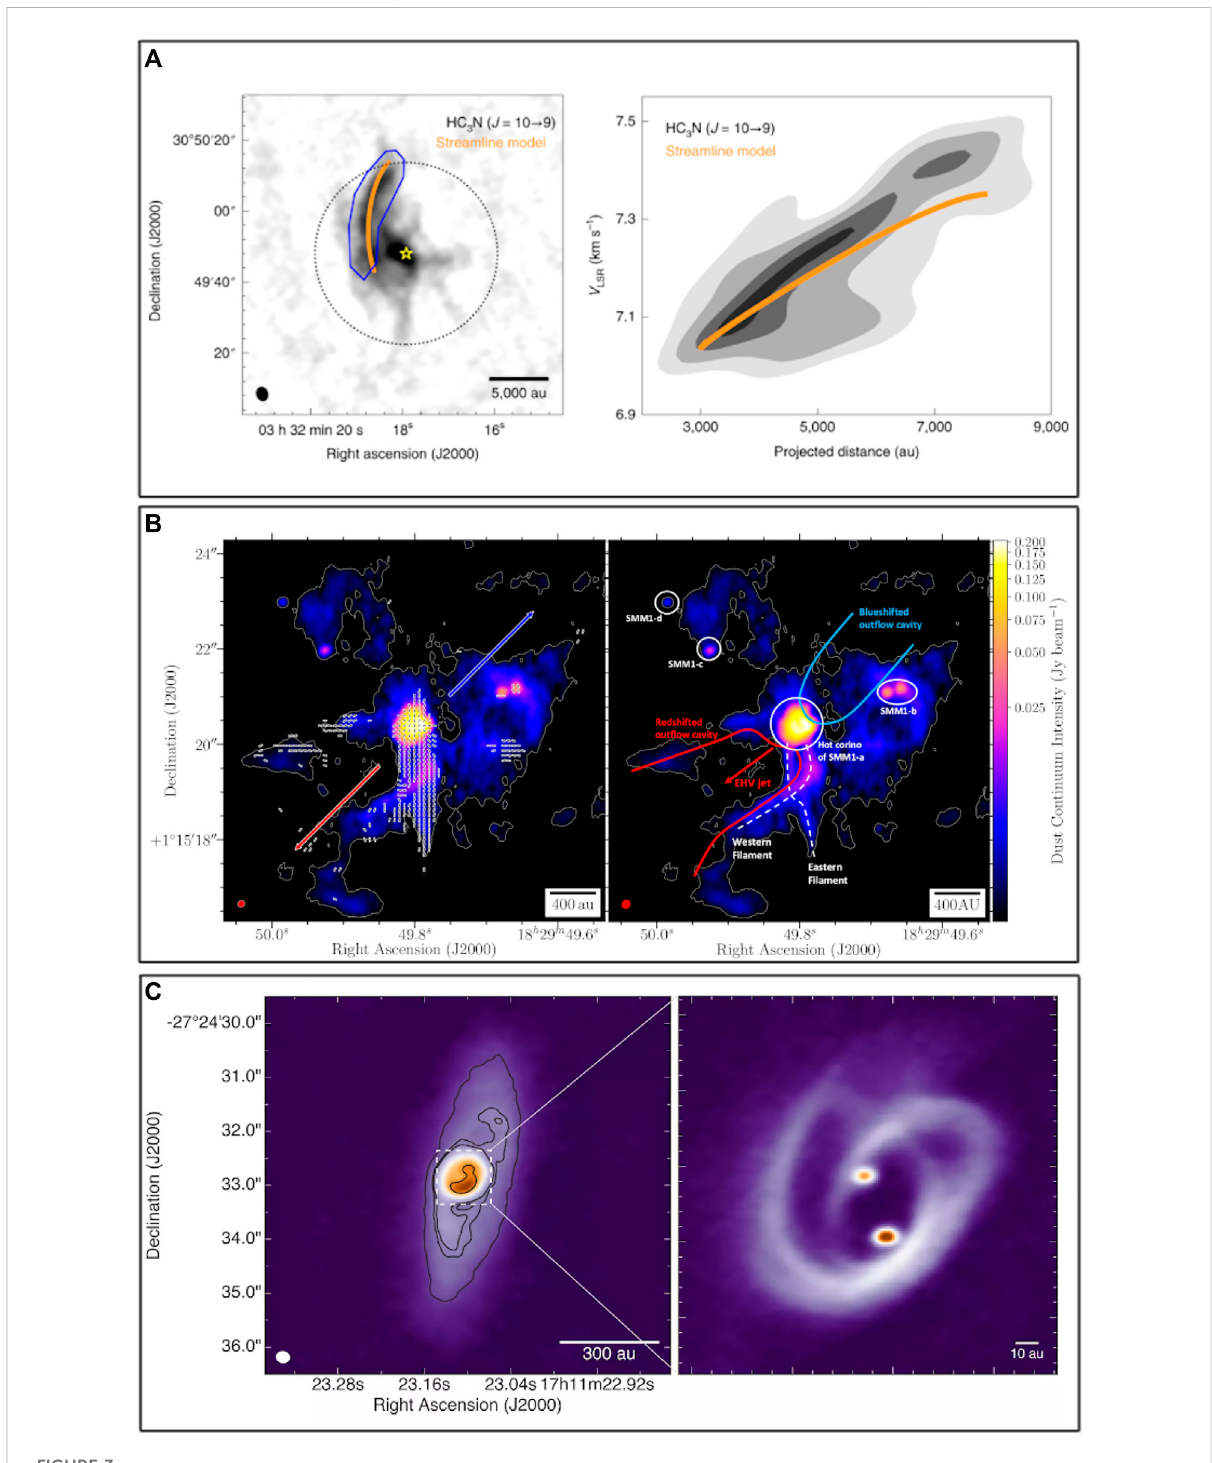
FIGURE 3 Streamer structures seen at different scales and towards different embedded protostars. (A) IRAS 03292+3039 in Perseus (Pineda et al., 2020). (B) Serp-SMM1 in Serpens (Le Gouellec et al., 2019). (C) [BHB2007] 11 in the Pipe (Alves et al.,